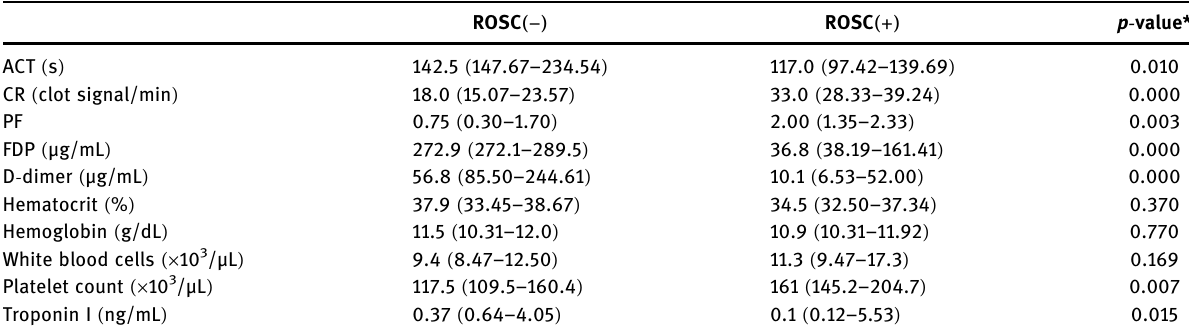
Table 3: Comparisons of ACT, CR, PF, FDP levels, D - dimer levels, complete blood count, and troponin I levels between the ROSC (+) and ROSC ( − ) groups